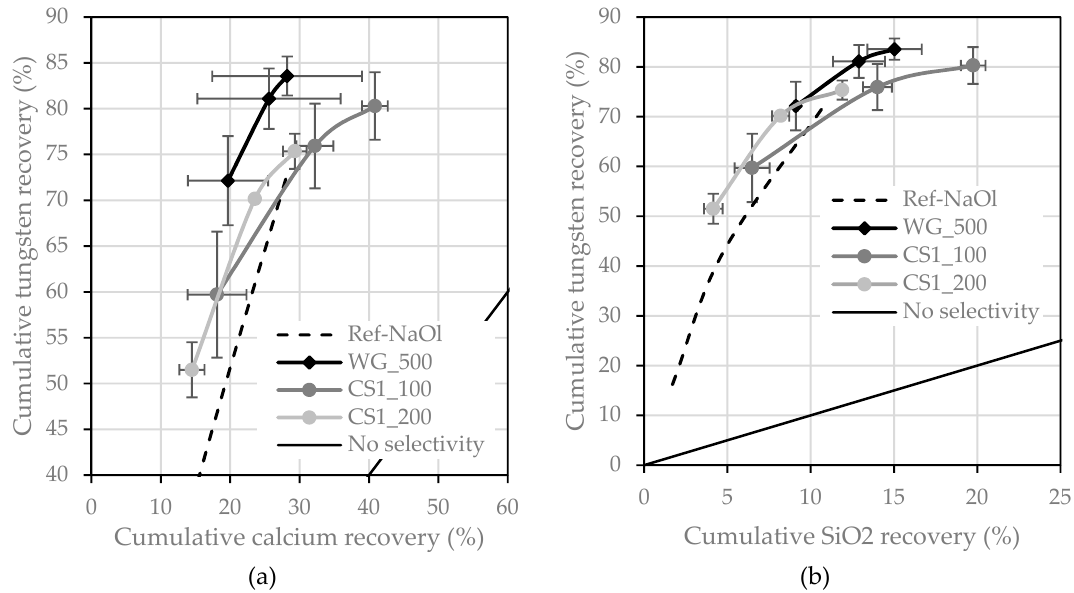
Figure 7. Selectivity curves of tungsten against ( a ) calcium (calcium contained in scheelite was subtracted) and ( b ) silica (error bars represent the 95% confidence interval).